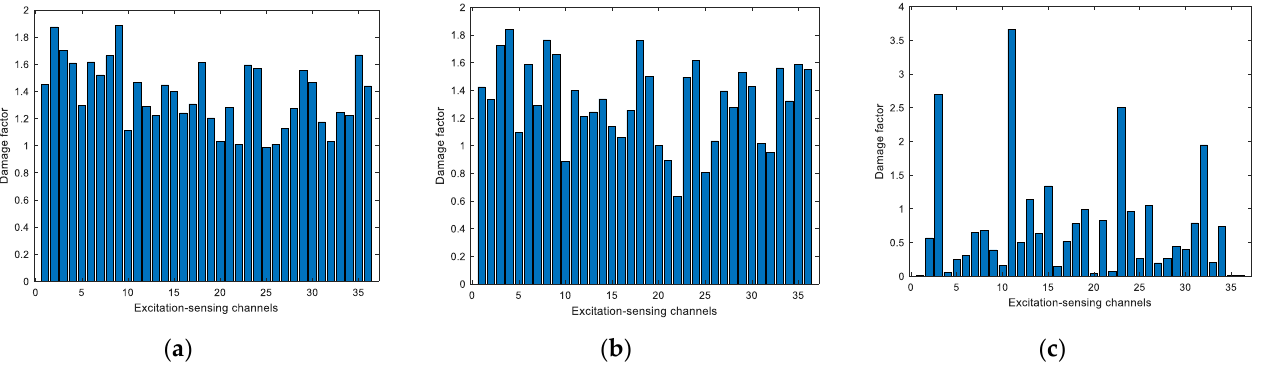
Figure 7. Damage scattering signals and sparse representation signals of 2 – 8 channels.